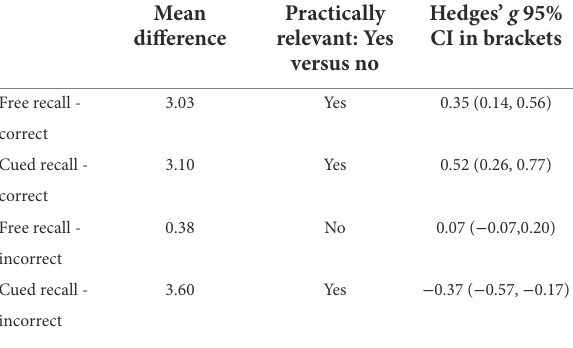
TABLE 1 Practical relevance of the detected mean differences.